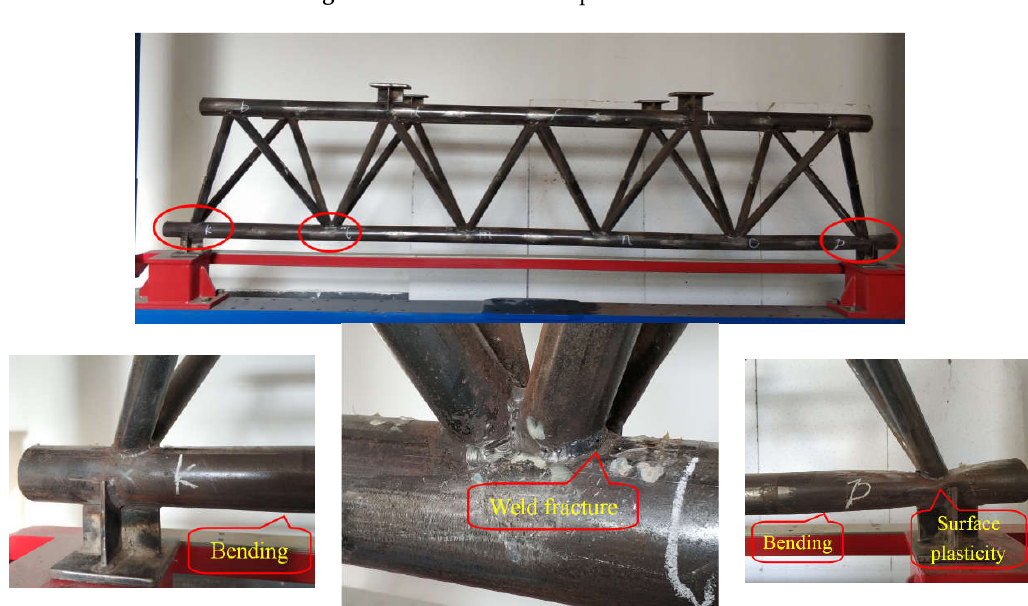
Figure 6. Failure modes of specimen T-HN.